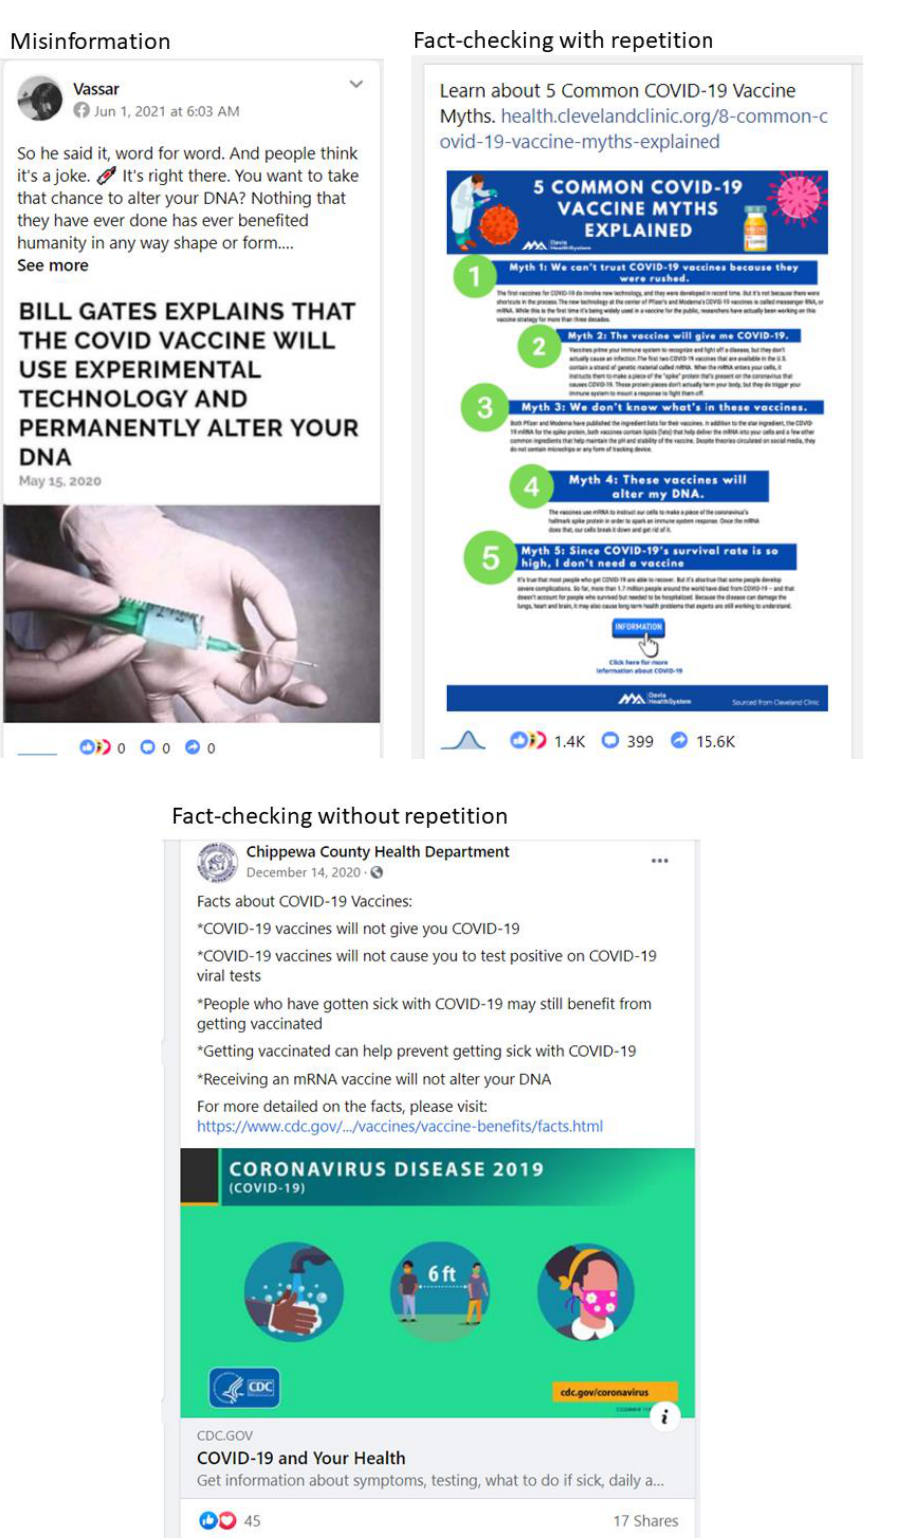
Figure 1. Example posts of misinformation, fact-checking with repetition, and fact-checking without